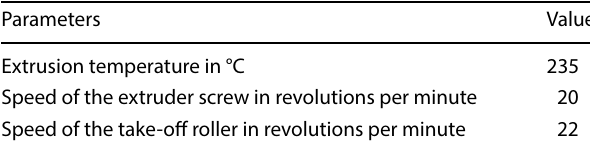
Table 3 Parameters used for filament production from PETG